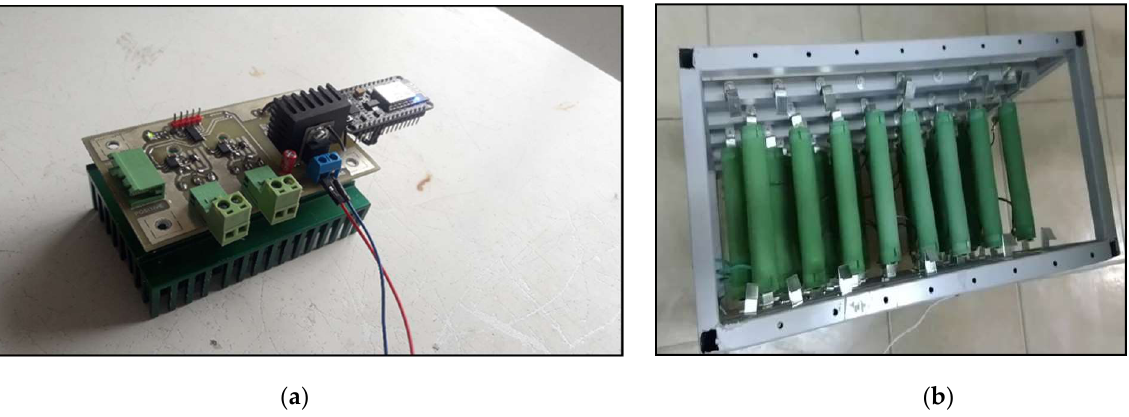
Figure 18. ( a ) Experimental prototype of chopper with WiFi communication, ( b ) resistance bank (dump load).